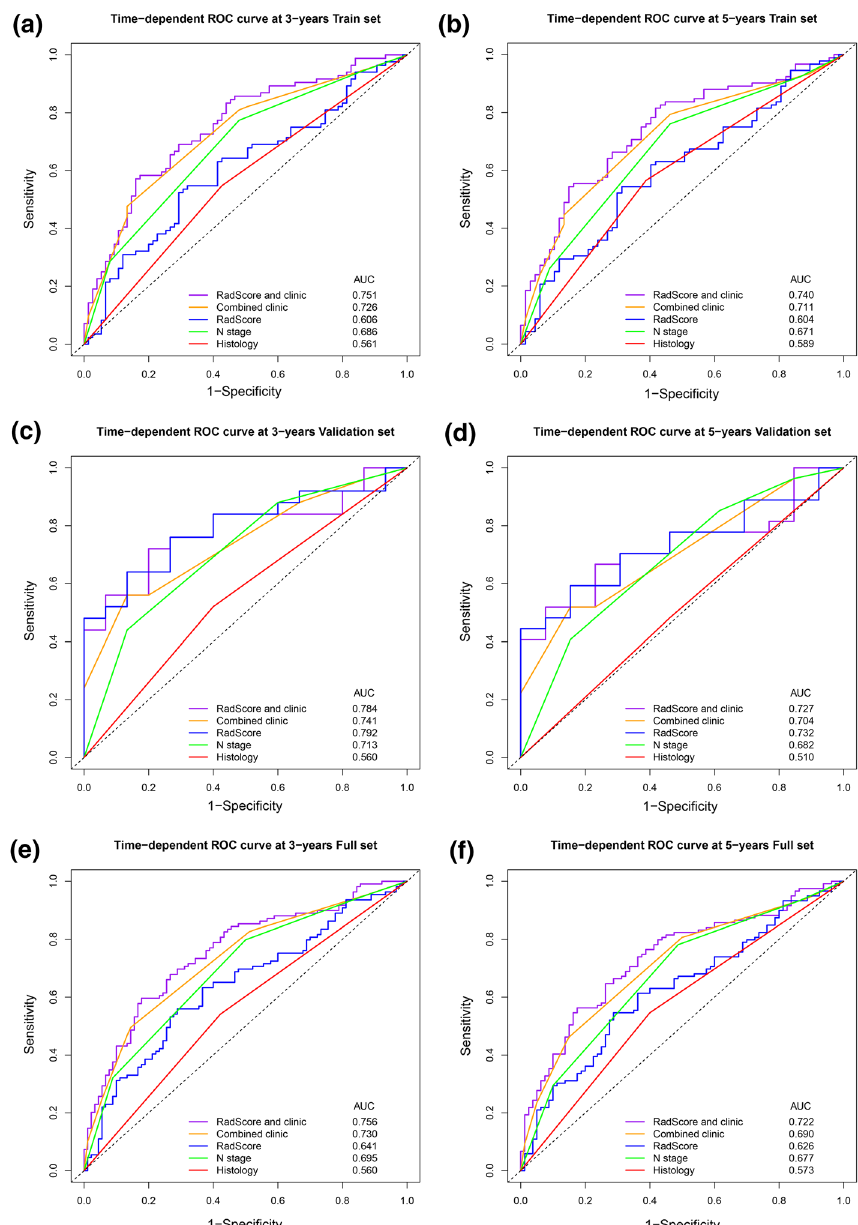
Fig. 4 Time-dependent ROC curves compare the prognos- tic accuracy of the Rad-Score with clinicopathological risk factors in the training set ( a , b ), validation set ( c , d ), and the combined set ( e , f ) with NPC of 3-year and 5-year disease